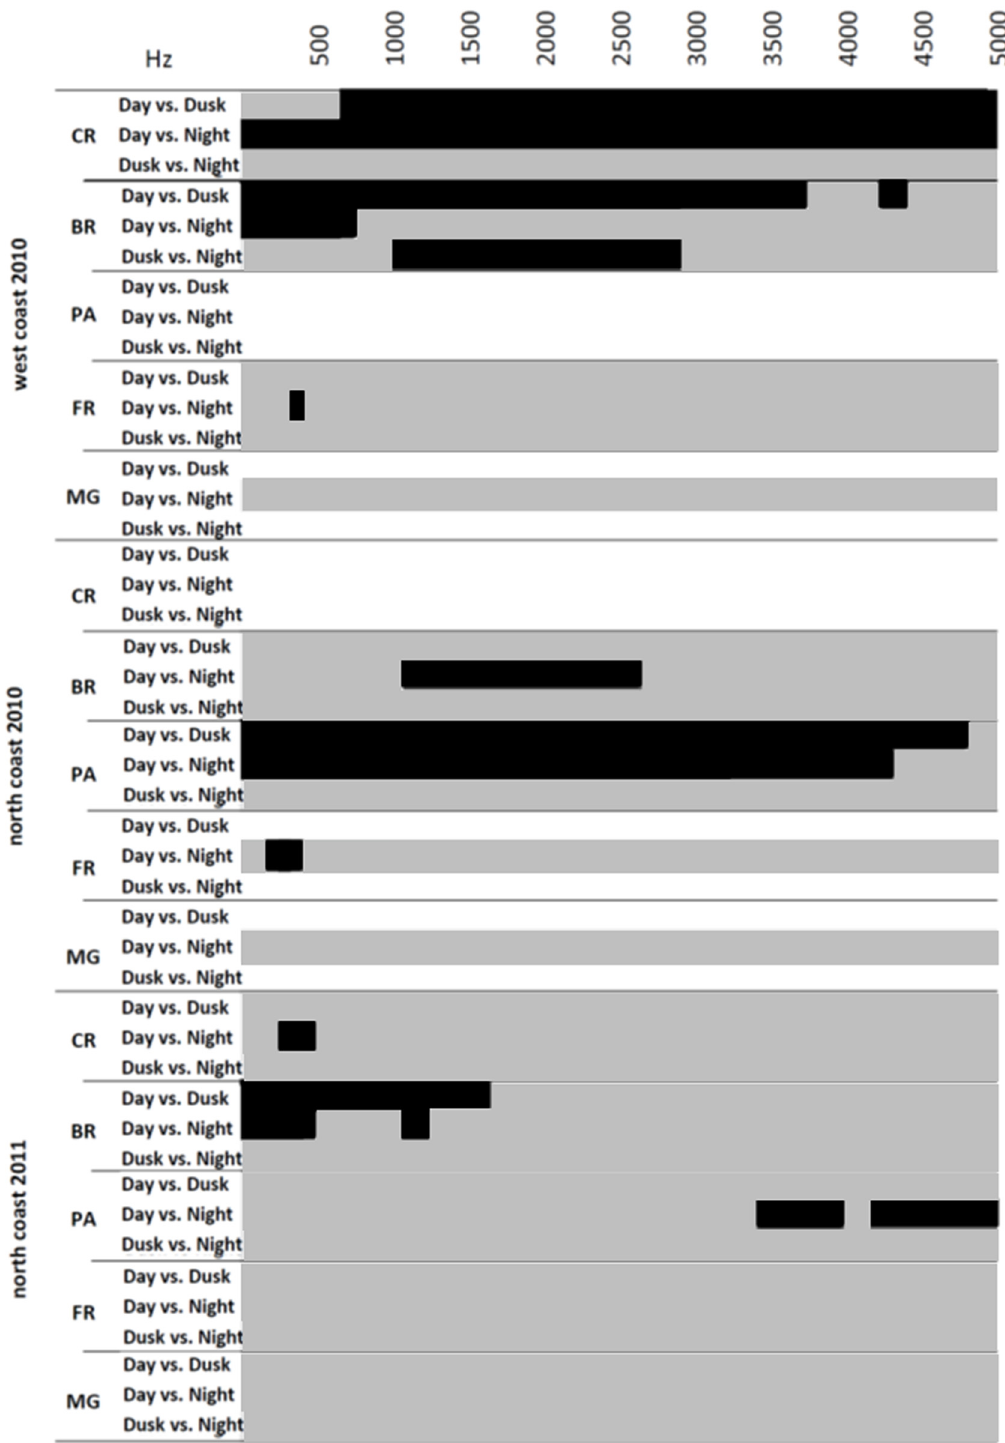
Fig 2. Comparison of sound intensities between day periods. Results of sampled frequencies (Fast Fourier Transform FFT, 512 points Hamming window, 86.13 Hz resolution, in the 20 – 5000 Hz range) at the West Coast in 2010 (top), the North Coast in 2010 (middle) and the North coast in 2011 (bottom). Black = P < 0.05. Grey = non-significant difference (Tukey ’ s multiple comparison post-hoc test). White = no data available.